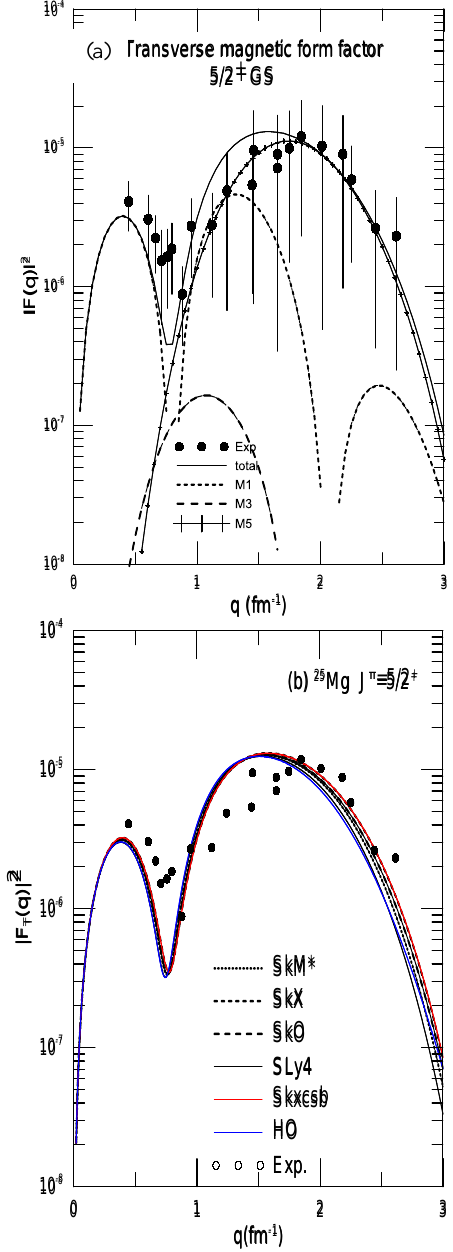
Fig. 1: The total theoretical magnetic form factor for GS of 25 Mg J π =5/2 + nuclei compared with experimental data [18] (a) using SkXcsb parameterization (b) using different Skyrme parameterizations and